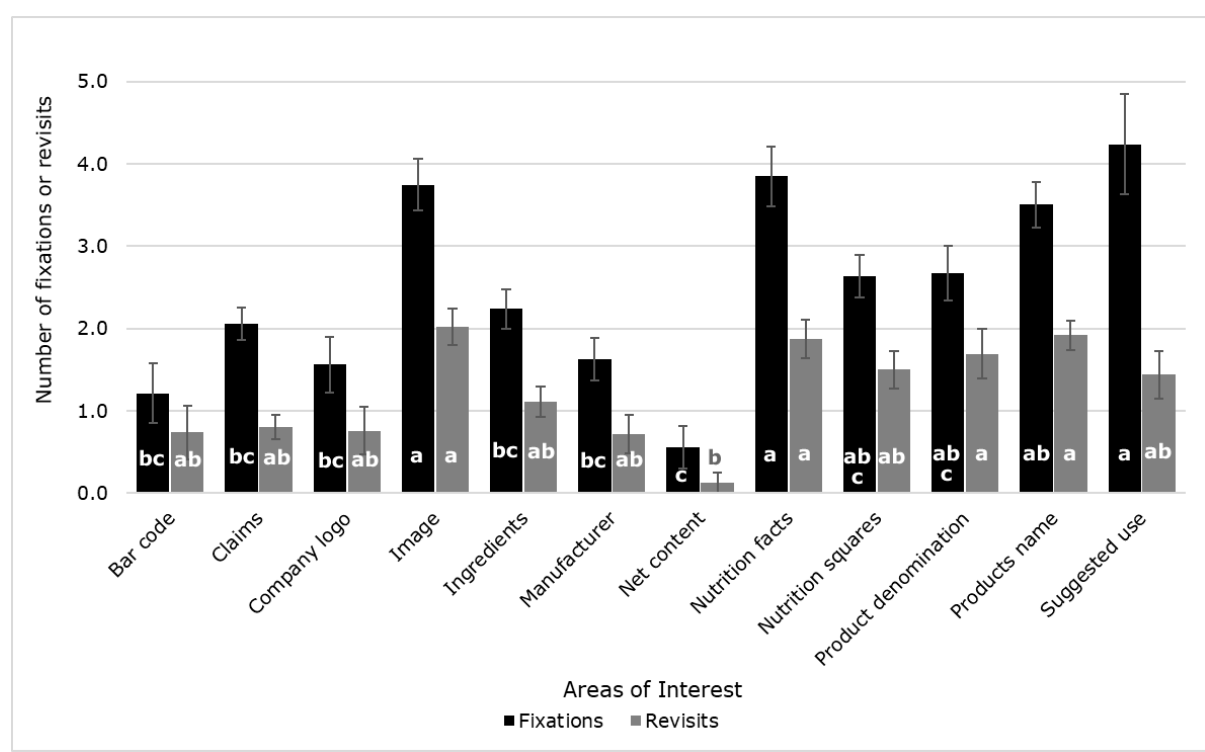
Figure 5. Mean values of the number of fixations and revisits from the eye-tracking analysis of the labels evaluated. Error bars represent the standard error. Different letters denote significant differences based on the ANOVA and Tukey honest significant difference (HSD) post hoc test ( α = 0.05).